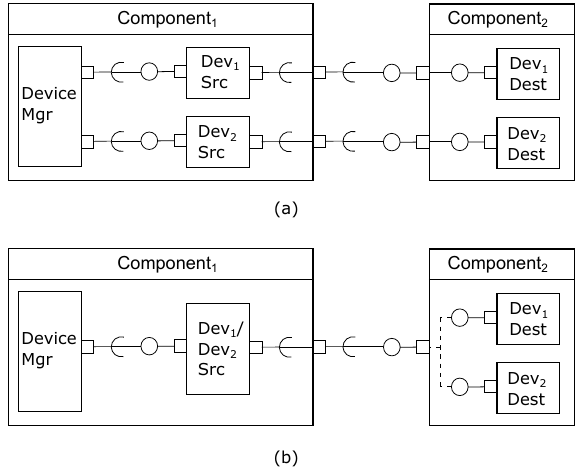
Figure 18. Handling Redundant Devices on the Platform: ( a ) Existing design: Dedicated communica- tion channel for each device. ( b ) Updated design: Single communication channel for multiple devices using an enhanced connector inside Component 2 .